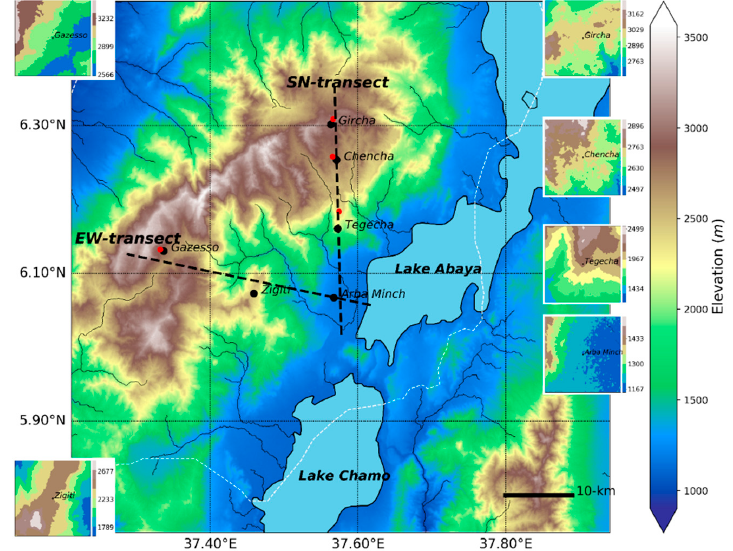
Figure 1. Six GEMS stations network (black dots) and potato experimental farms (red dots). The large digital elevation model covers an area of 80 km × 80 km and the insets with detailed topography map cover 5 km × 5 km area. The dashed black lines show the south–north (SN) and east–west (EW) transects of the network. The dashed white line represents the approximate southeast (SE) boundary of the Gamo Highlands.